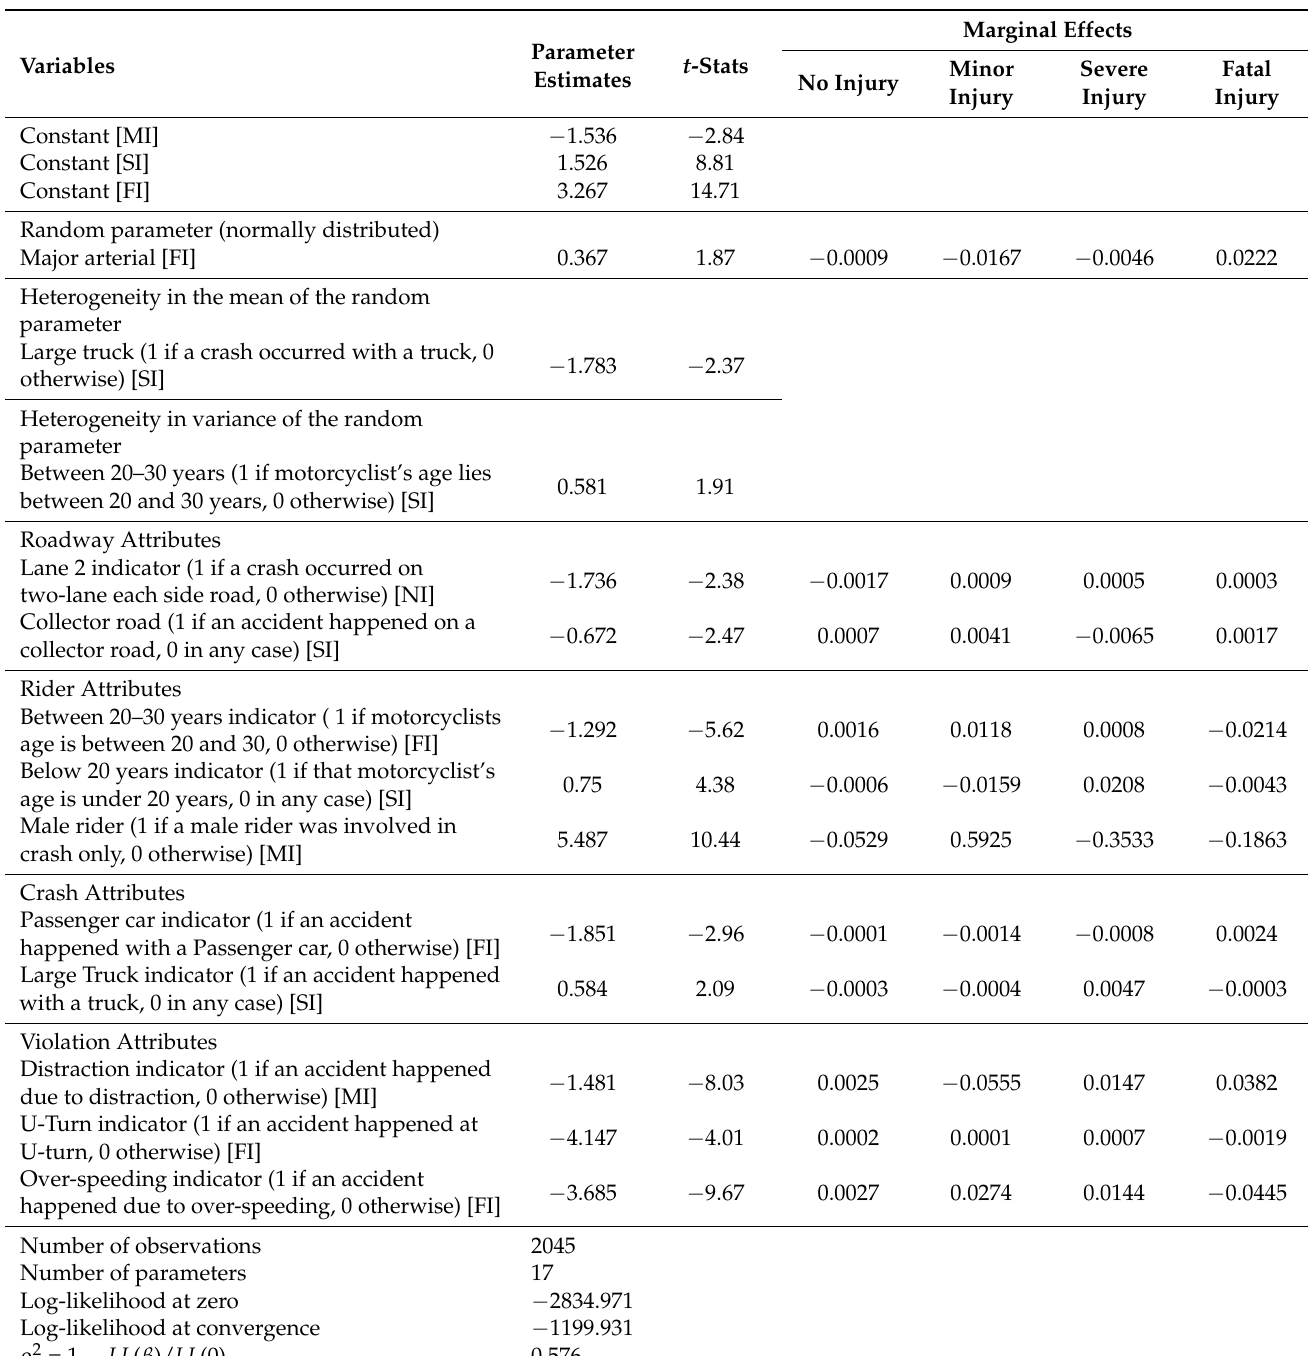
Table 6. Model estimation results for helmet-wearing motorcycle crashes